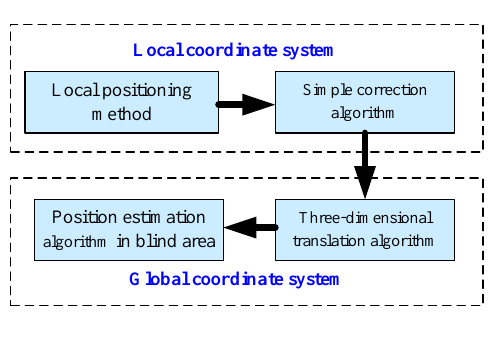
Figure 5. Global positioning